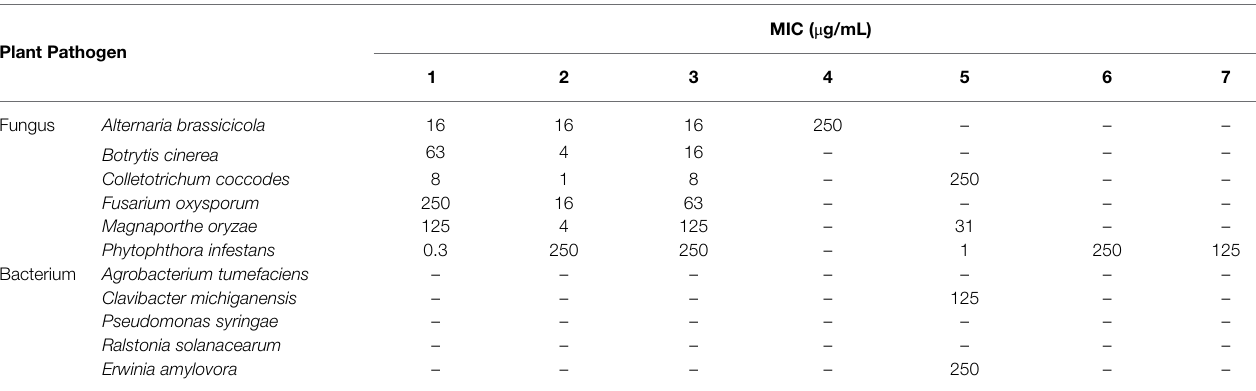
TABLE 3 | In vitro antimicrobial activity of compounds 1 – 7 against plant pathogen.